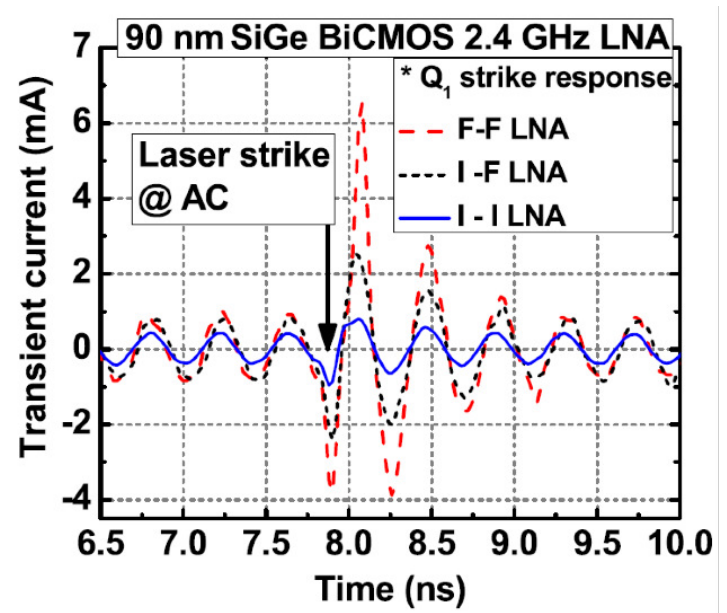
Figure 4. Dynamic interference in different low-noise amplifiers generated by pulse-laser induced SEE experiment. For the core cascode stages, either forward (F) or inverse (I) mode SiGe HBTs are used. Used with permission from